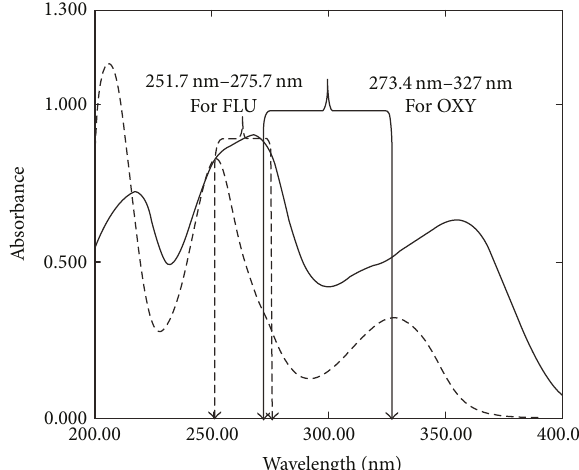
Figure 2: Zero-order spectra of 25 𝜇 g/mL OXY (—) and 25 𝜇 g/mL FLU (-----) using 0.1 NHCl as a